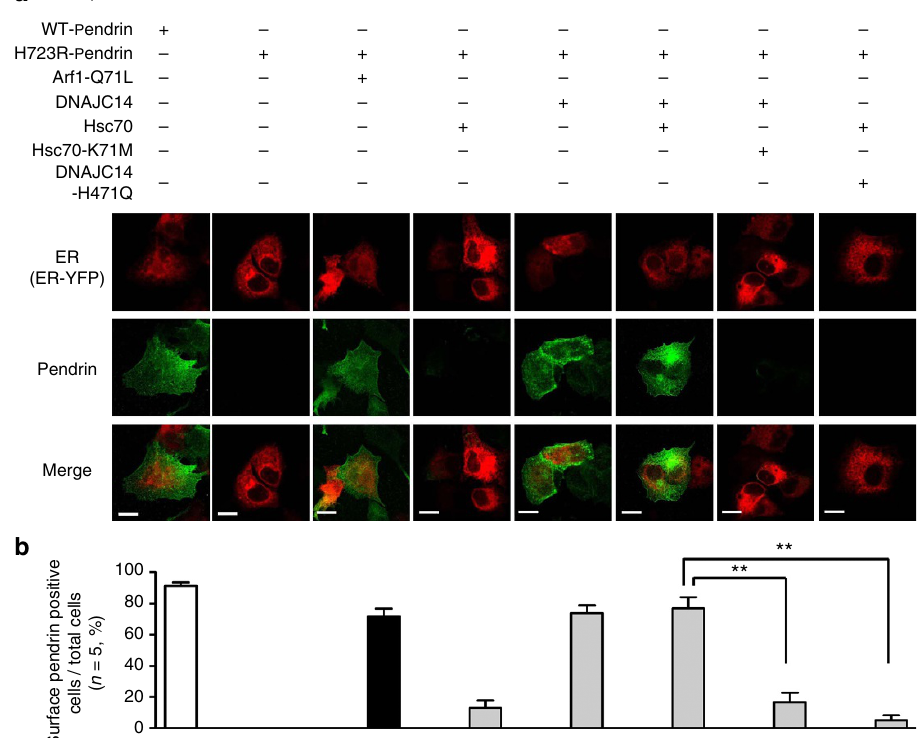
Figure 9 | DNAJC14 restores cell-surface expression of H723R-pendrin in immunostainings. The cell-surface expression of wild-type (WT) and H723R pendrins were examined in non-permeabilized PANC-1 cells. The ER marker protein ER-YFP was co-expressed. Representative images are shown in a. Quantitation of results from five independent experiments is shown in b . Note that the Hsc70-K71M and DNAJC14-H471Q mutations strongly inhibited the ability of DNAJC14 to rescue H723R-pendrin at the cell surface. Scale bar, 20 m m. ** P o 0.01 by one-way analysis of variance, n ¼ 5.